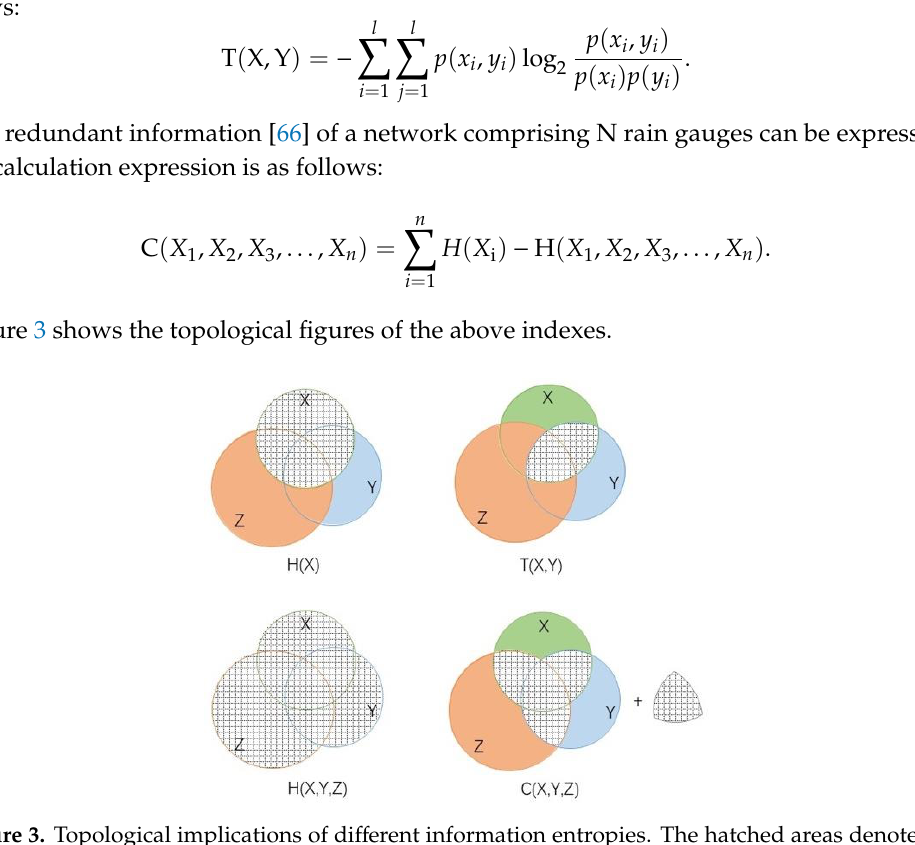
Figure 3. Topological implications of different information entropies. The hatched areas denote the areas that correspond to the stated expressions.